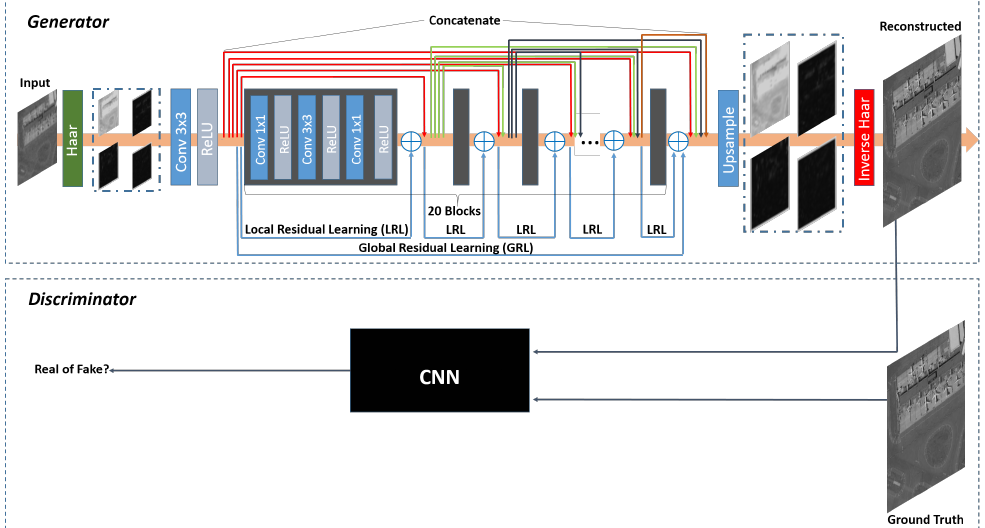
Figure 4. The architecture of